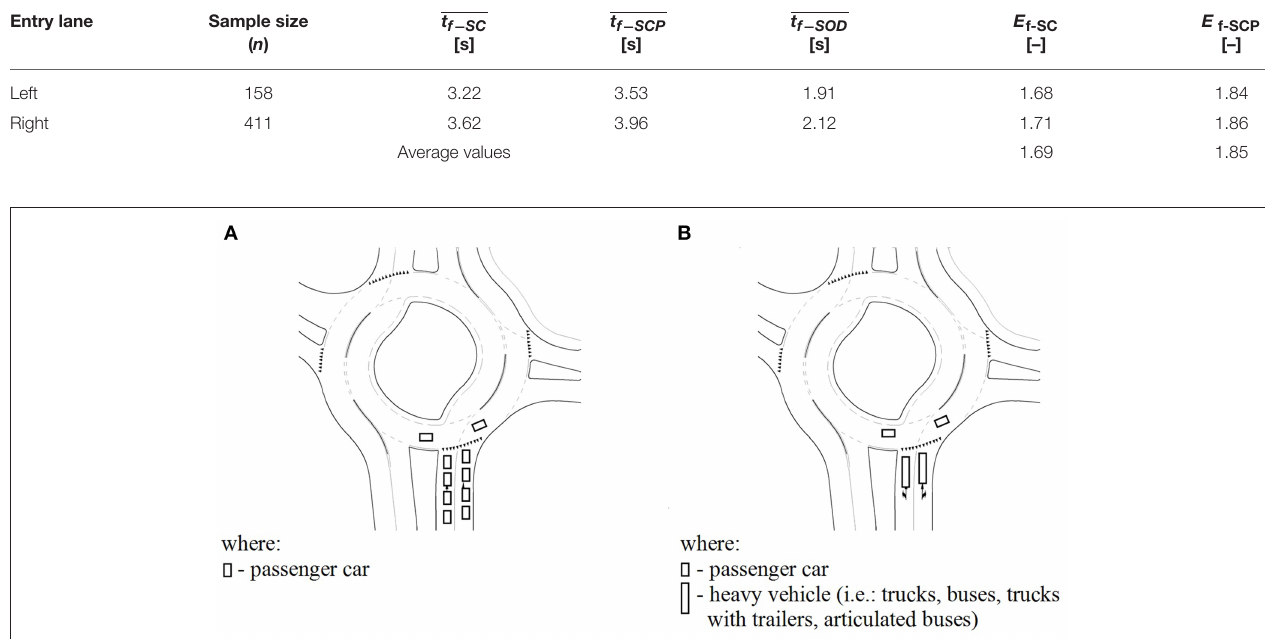
TABLE 4 | The passenger car equivalent factors for follow-up times between the vehicles entering on the circulatory roadway from the turbo roundabout entry lanes.